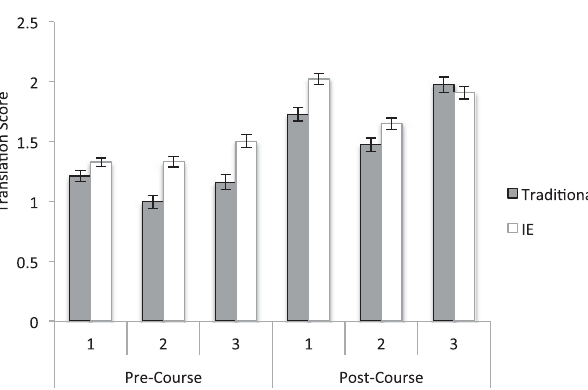
FIG. 4. Pre- and postcourse execution accuracy score as a function of problem number and class format (total possible score ¼ 3 ). Error bars represent the standard